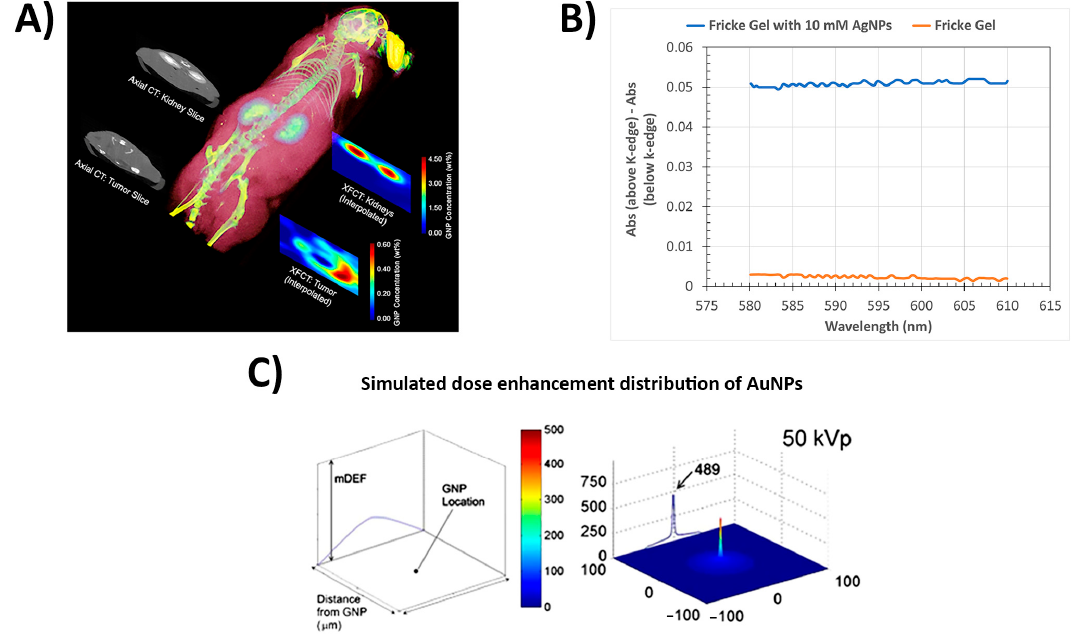
Figure 7. Application of high- Z nanoparticles as contrast agents and dose enhancement measure- ments. ( A ) Example of gold nanoparticles for contrast enhancement illustrating the possibility of quantitative multimodal imaging of AuNP distributions in an animal using X-ray fluorescence computed tomography (XFCT) and conventional CT together (reproduced with permission from reference [160]. ( B ) Experimental dose enhancement in Fricke gel dosimetry with AgNPs irradiated with energies below and above the k-edge of silver. ( C ) Spatial variation in mDEF around a AuNP. mDEF represents the factor by which the dose would be increased by replacing a hypothetical water nanoparticle with a AuNP. The results are shown along the radial direction from a AuNP at the center. (Adapted and reproduced with permission from reference